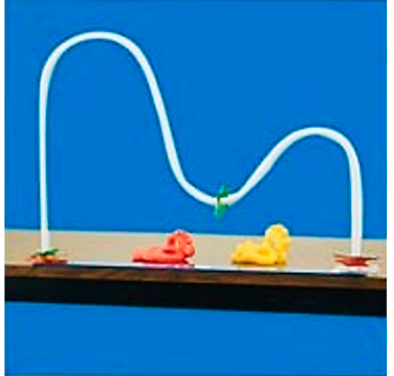
Figure 1. Traditional rehabilitation; double-curved shoulder arc.